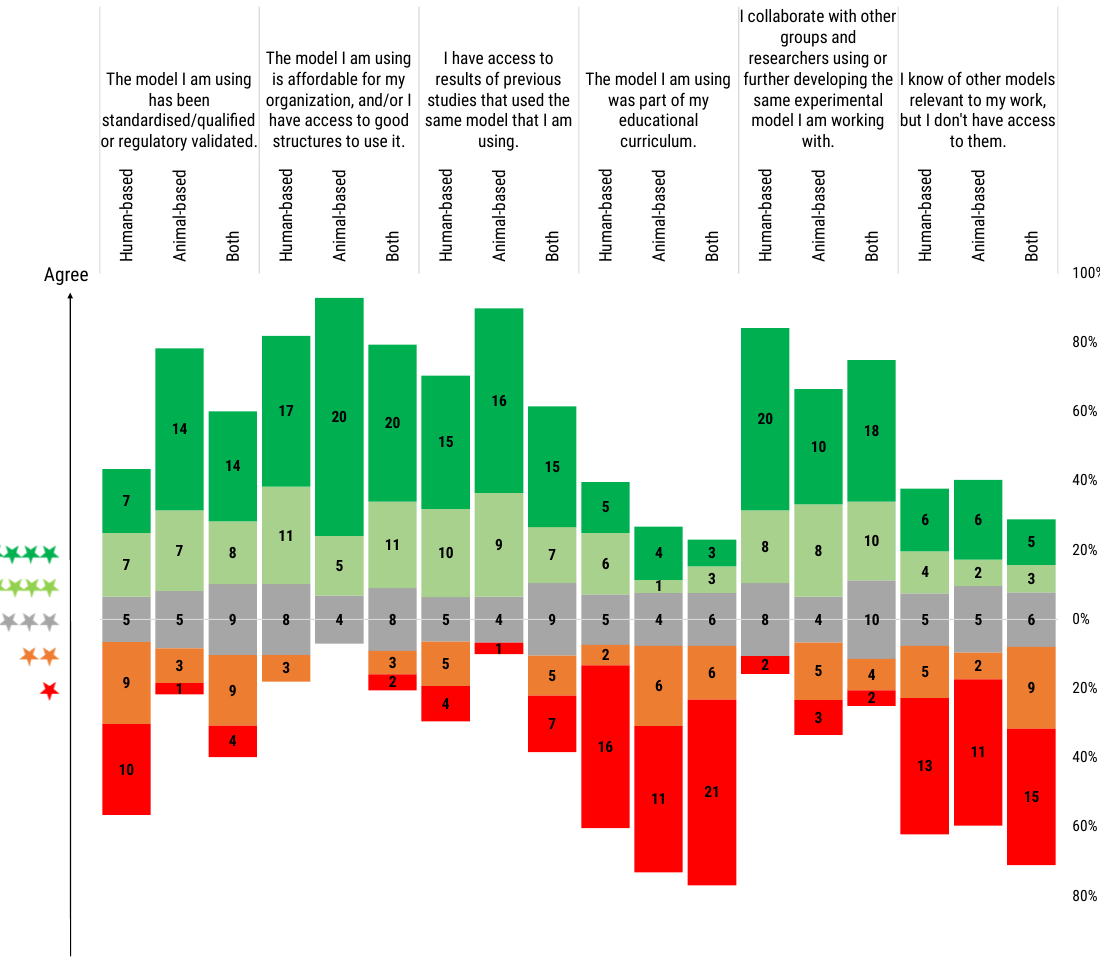
Figure 3. Participants were asked to rate the following statements regarding the use of models. Rating scale was from 1 (red) to 5 (green) stars. Histogram dimensions are represented as 100%, where 100% is the total number of participants of each subgroup: human-based (39), animal-based (30) and both (44) model users. The stacked chart, calibrated around the neutral score (3 stars), shows the number of respondents based on their degree of agreement and segmented by researchers’ use of animal- or human-based or both models.